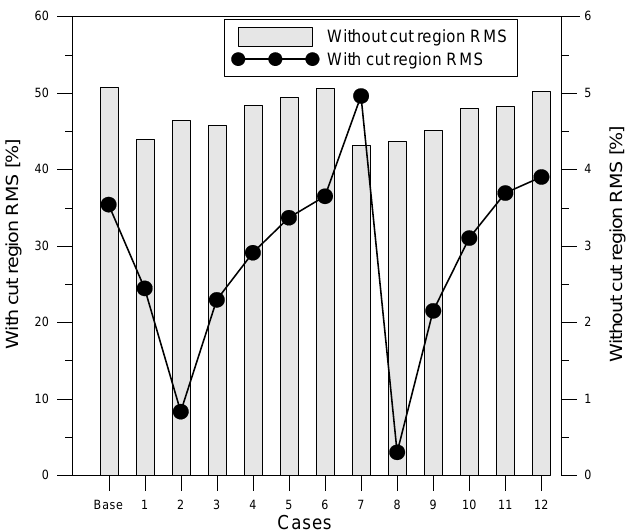
Figure 12. RMS error results by cases listed in Table 5.